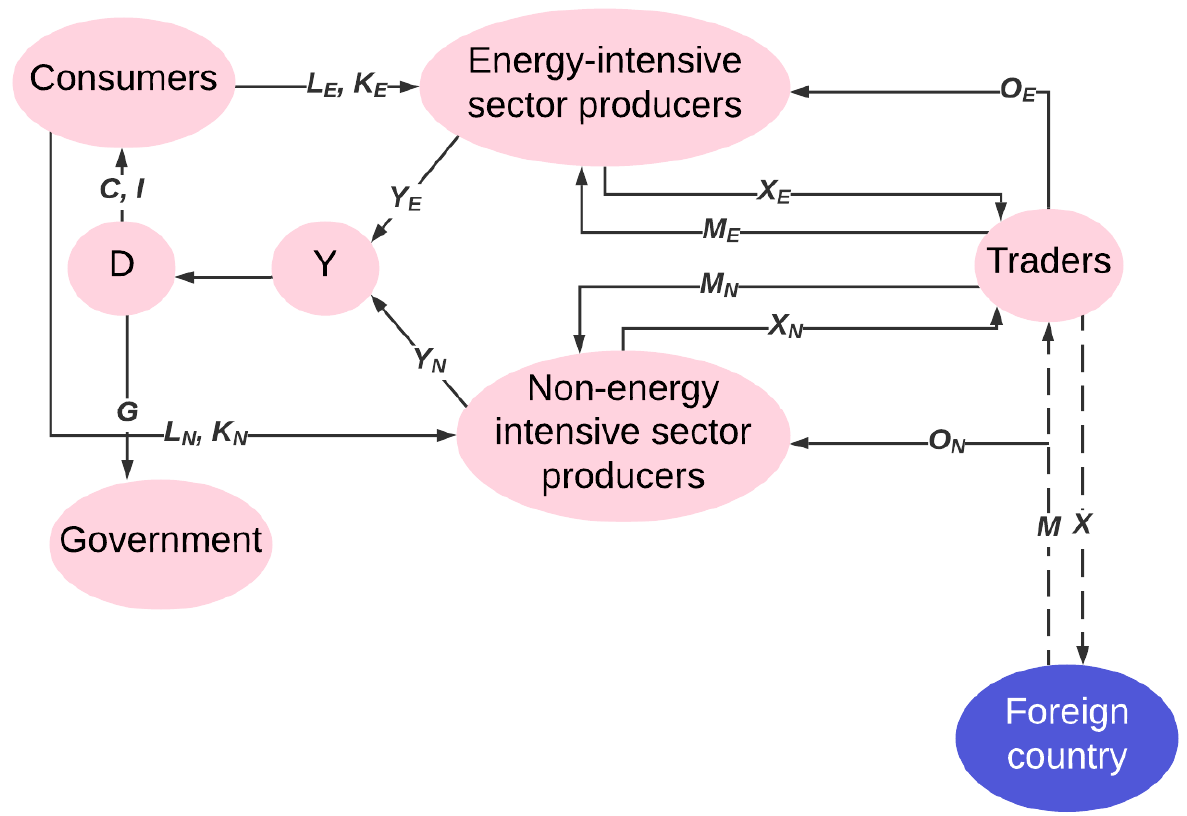
Figure 1. The structure of the model.